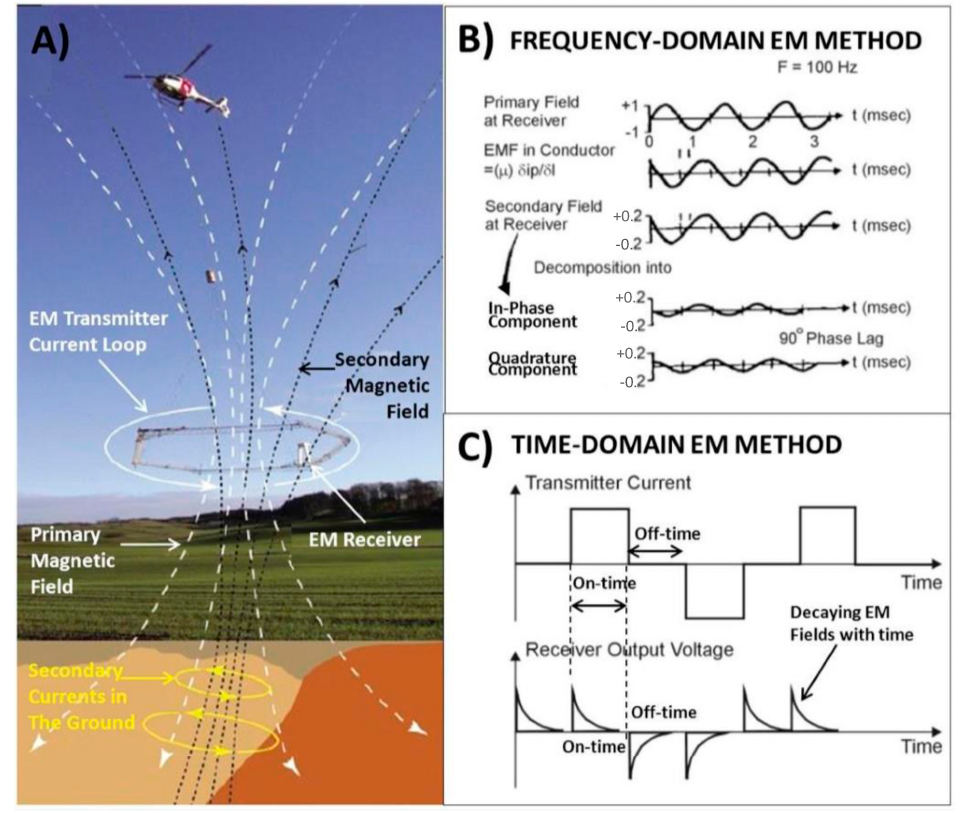
Figure 3. AEM acquisitions technique [46]: ( A ) airborne method, ( B ) measure in frequency domain, ( C ) measure in time domain.